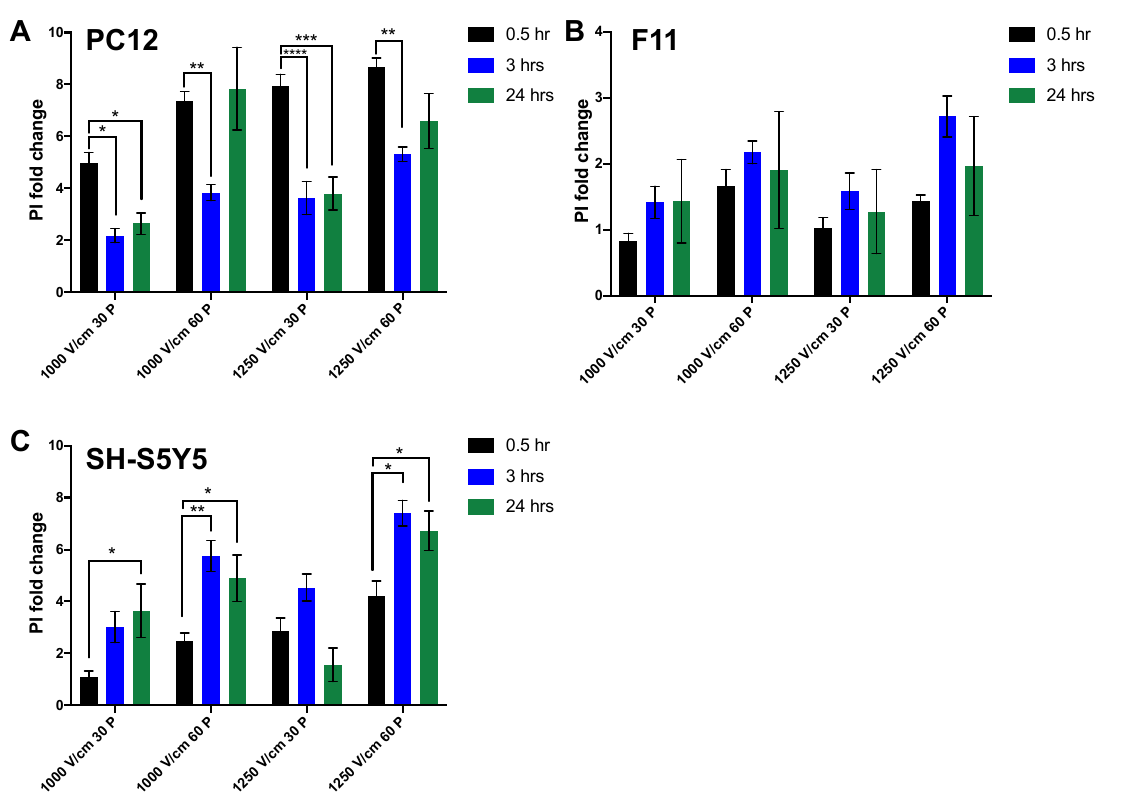
Figure 5. Temporal dynamics of neuronal cell death in response to electroporation. The evolution of membrane permeability to PI waw measured at 0.5 (in black), 3 (in blue), and 24 (in green) hours after treatment of cells in suspension with IRE with amplitudes of 1000, 1250 V/cm in 30 and 60 P (pulses) in PC12 ( A ), F11 ( B ), and SH-S5Y5 ( C ) cells. All data shown as mean ± SEM. Statistical significance performed using two-way ANOVA (* p < 0.05, ** p < 0.005, *** p < 0.001, **** p < 0.0001). Table 1. Direct comparison of PI permeability among all neuronal lines at 0.5-hour time point.